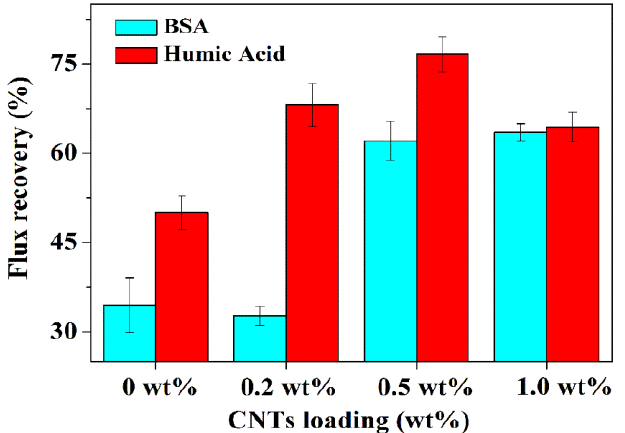
Figure 7. Flux recovery of alumina/polymer hollow fibre membranes with different CNTs